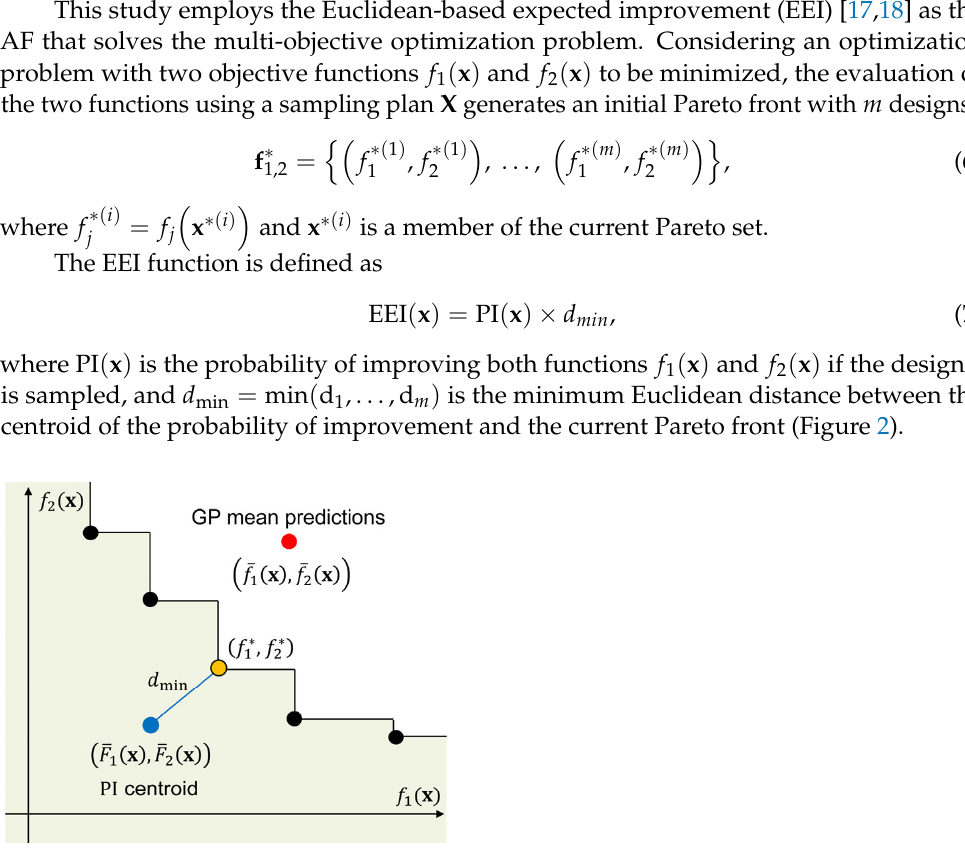
Figure 2. Euclidean ‐ based expected improvement. The black dots denote the current Pareto front. Figure 2. Euclidean-based expected improvement. The black dots denote the current Pareto front. The design 𝐱 has GP mean predictions 𝑓̅ (cid:2869) (cid:4666)𝐱(cid:4667) and 𝑓̅ (cid:2870) (cid:4666)𝐱(cid:4667) (red dot). The centroid of the probability ( x ) and f ( x ) (red dot). The centroid of the probability The design x has GP mean predictions f 1 2 of improvement ( 𝐹(cid:3364) (cid:2869) (cid:4666)𝐱(cid:4667) , 𝐹(cid:3364) (cid:2870) (cid:4666)𝐱(cid:4667) ) is denoted by the blue dot, and the closest Pareto design ( 𝑓 (cid:2869)∗ , 𝑓 (cid:2870)∗ ) is of improvement ( F 1 ( x ) , F 2 ( x ) ) is denoted by the blue dot, and the closest Pareto design ( f ∗ , f ∗ ) is 2 1 denoted by the orange dot. denoted by the orange